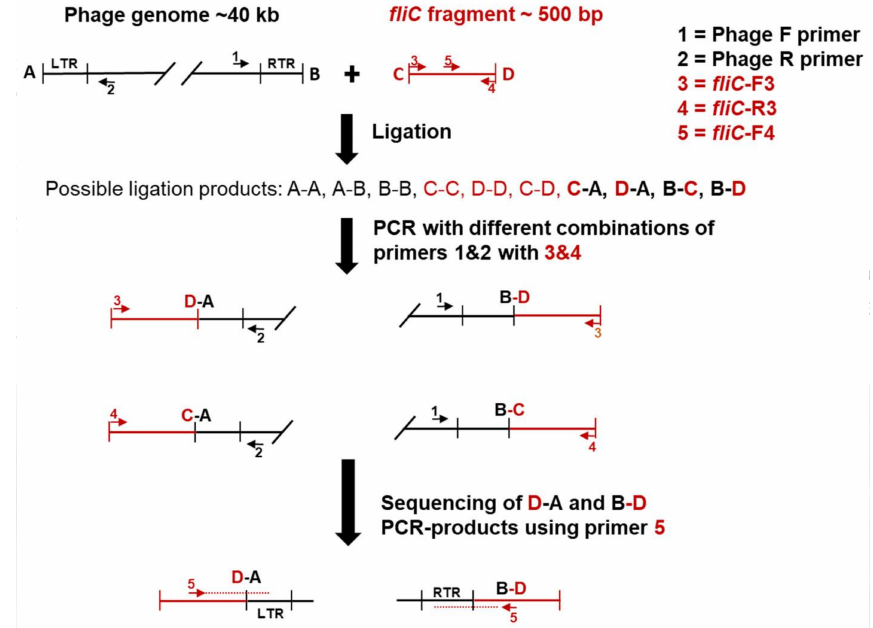
Figure 1. The ligation-polymerase chain reaction (PCR) strategy to determine the physical ends of bacteriophage genomes. The fliC fragment, its primers and directions are shown in red, and the phage genome, its primers and directions, in black. The predicted ends of the phage genomes and the fliC fragment are labeled by A & B, and C & D, respectively. First, the fliC gene fragment is blunt-end-ligated with phosphorylated intact phage genomic DNA. The ligation mixture is used as a template in PCR using fliC and phage specific primer pairs. The desired PCR-amplified ligation products are shown in bold. Finally, the D-A and B-D PCR-products are sequenced with a nested fliC specific primer fliC -F4. The resulting PCR products were analyzed in 0.8% agarose gel (BMA, Rockland, ME, USA) running at 100 V for 50 min. Then, the correct-sized PCR products were gel-purified from eight parallel PCRs using a gel purification kit (E.Z.N.A Gel Purification kit, Omega Bio-Tek, Inc., Norcross, GA, USA) after running the combined samples in a 1% low melting agarose gel (BMA, Rockland, ME, USA). DNA concentration and quality were determined using the NanoDrop spectrophotometer ND-1000 (Wilmington, DE, USA). Finally, to identify the physical ends of the genomes, the purified fragments were sequenced at FIMM using a fliC -F4 primer that pointed towards the physical end of the phage genome. The ligation-PCR was carried out with phages fPS-7 and fPS-26. The primers used in this work (Oligomer Oy, Helsinki, Finland) are listed in Table